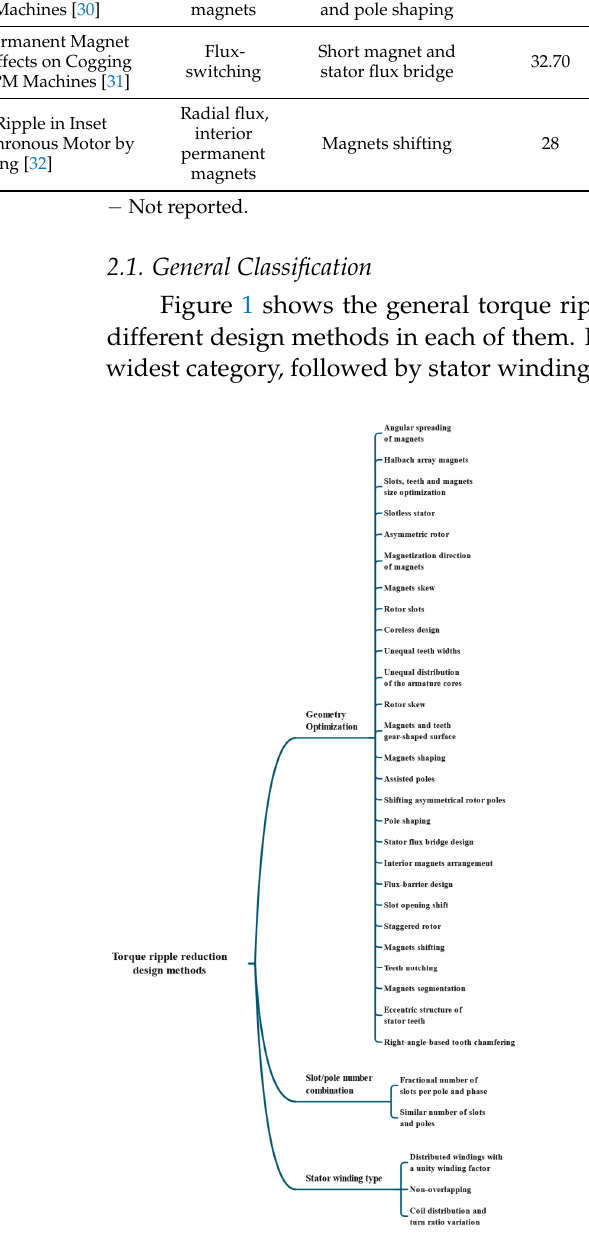
Figure 1. General classification of torque ripple reduction design